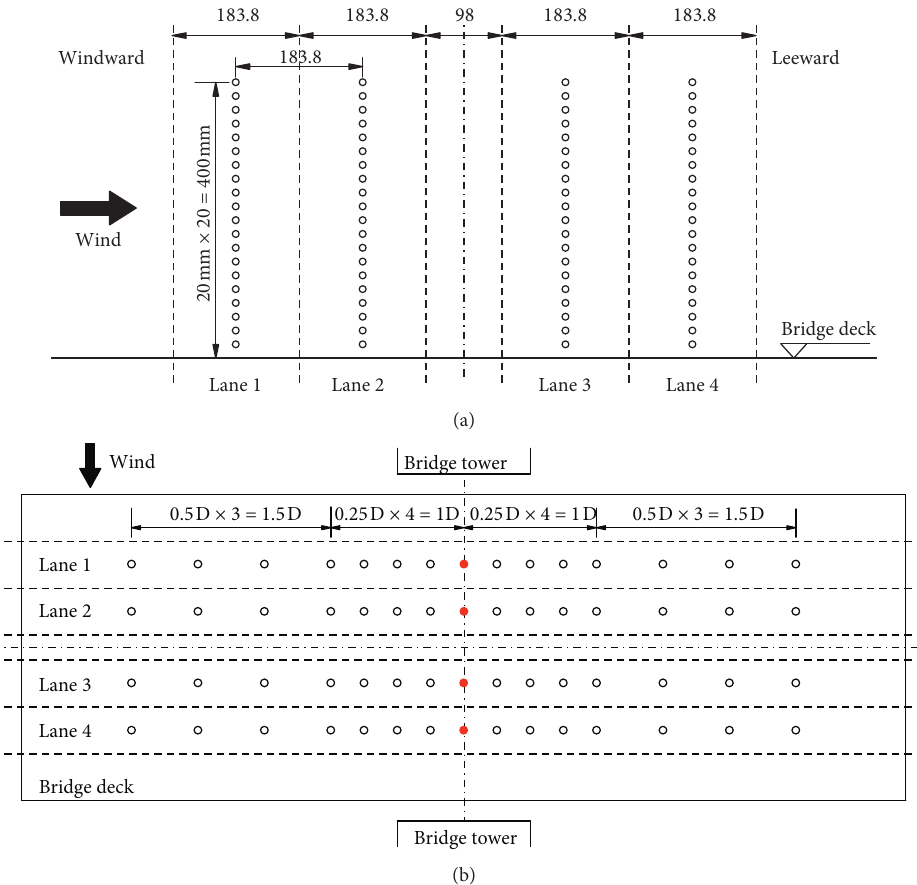
Figure 6: Locations of wind speed measurement points in tests (units: mm): (a) elevation view; (b) top